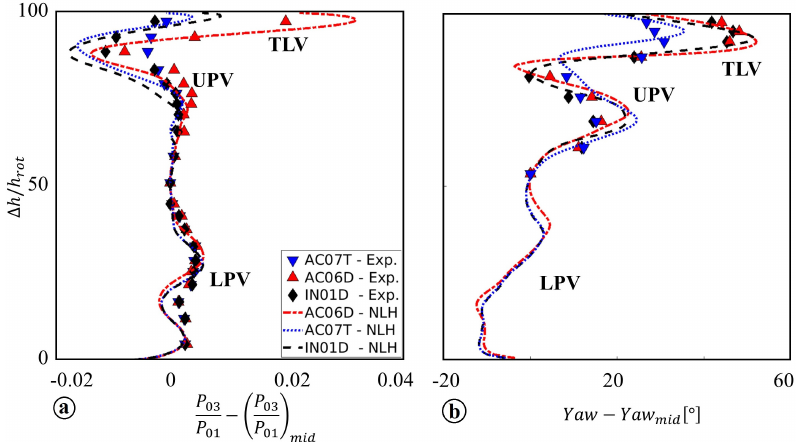
Figure 7. Time-average pitch-average radial distributions of P 03 / P 01 ( a ) and absolute outlet flow angle ( b ) for the three tip profiles.